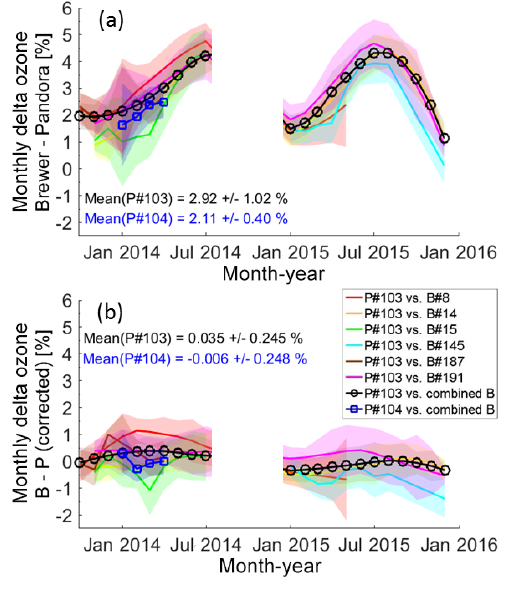
Figure 11. Monthly mean time series of the (Brewer − Pandora) / Brewer % TCO difference: (a) before applying the Pandora temperature dependence correction and (b) after applying the correction. The shaded regions represent 1 σ uncertainty.